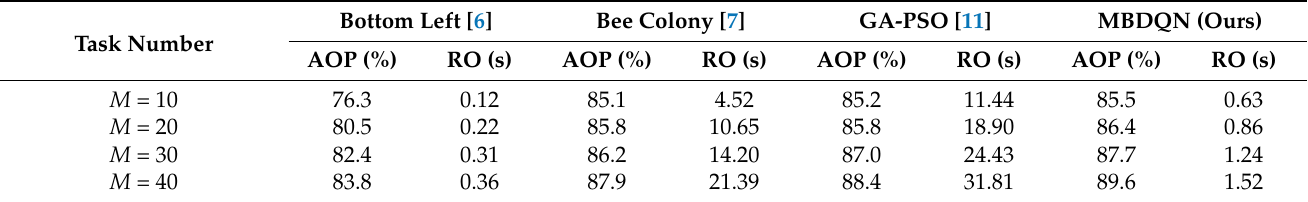
Table 6. Comparisons of the proposed MBQDN with existing methods [6,7,11] on the non-zero waste